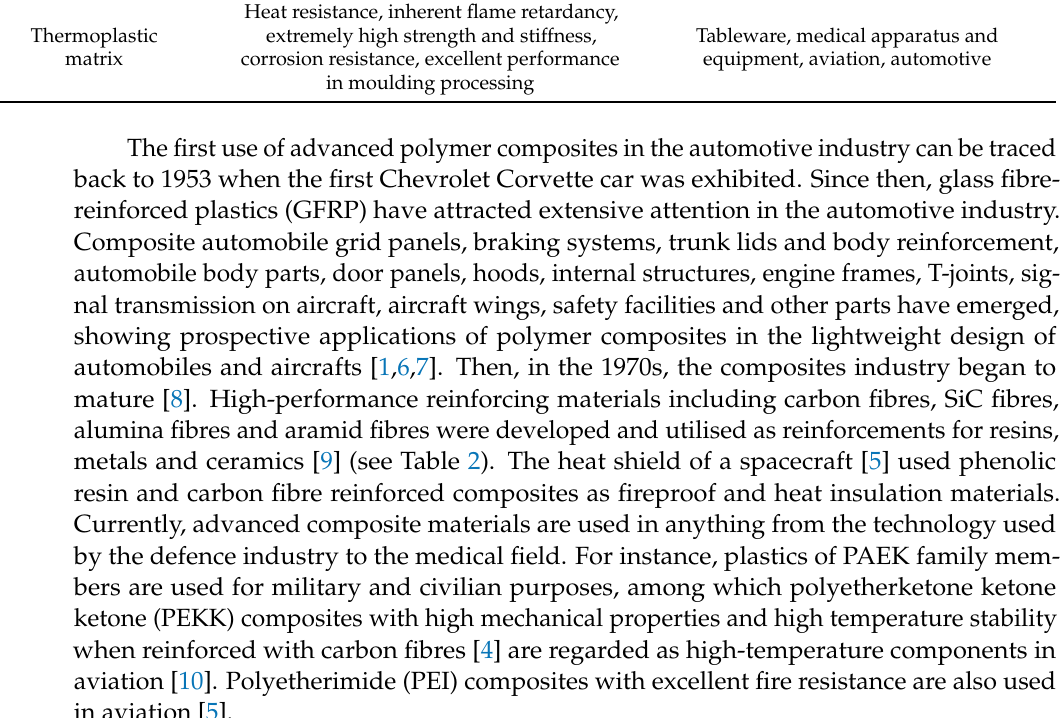
Tableware, medical apparatus and equipment, aviation, automotive